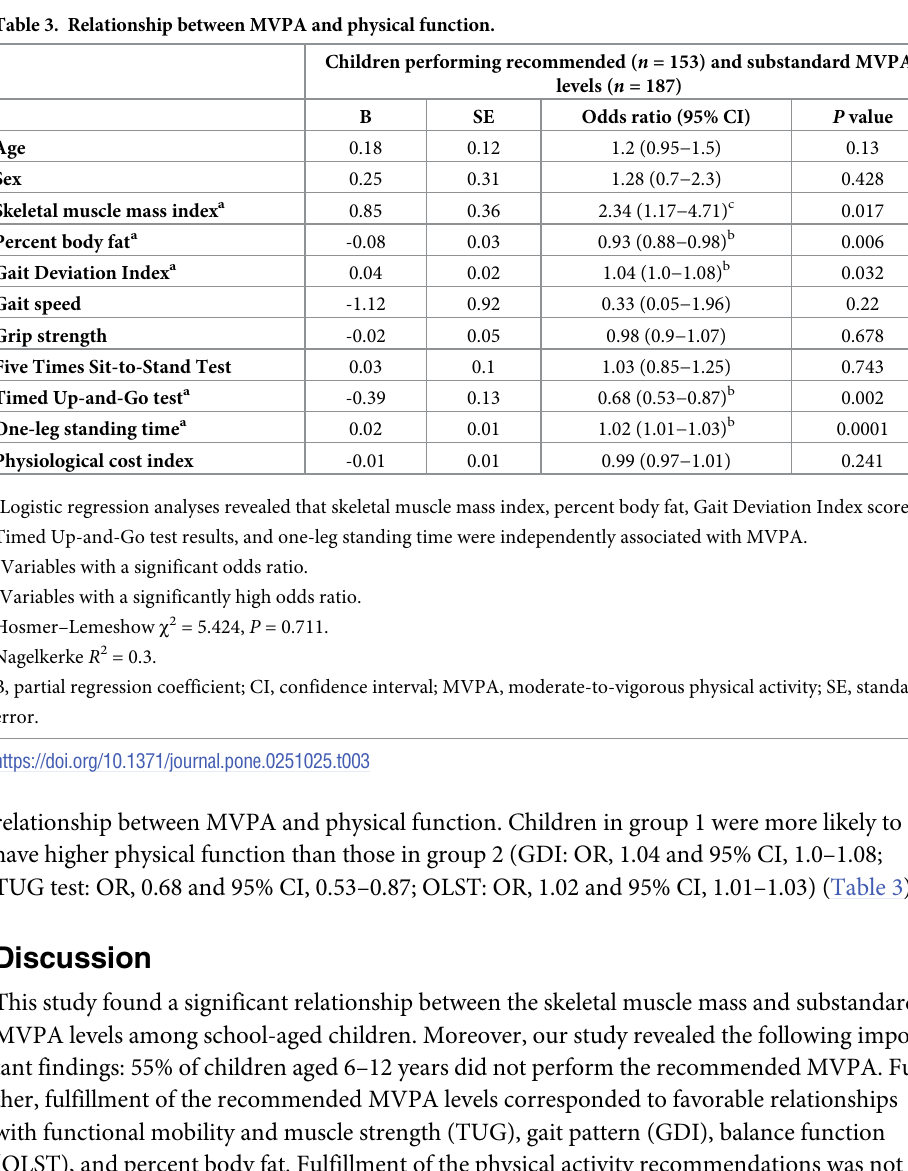
Table 3. Relationship between MVPA and physical function.